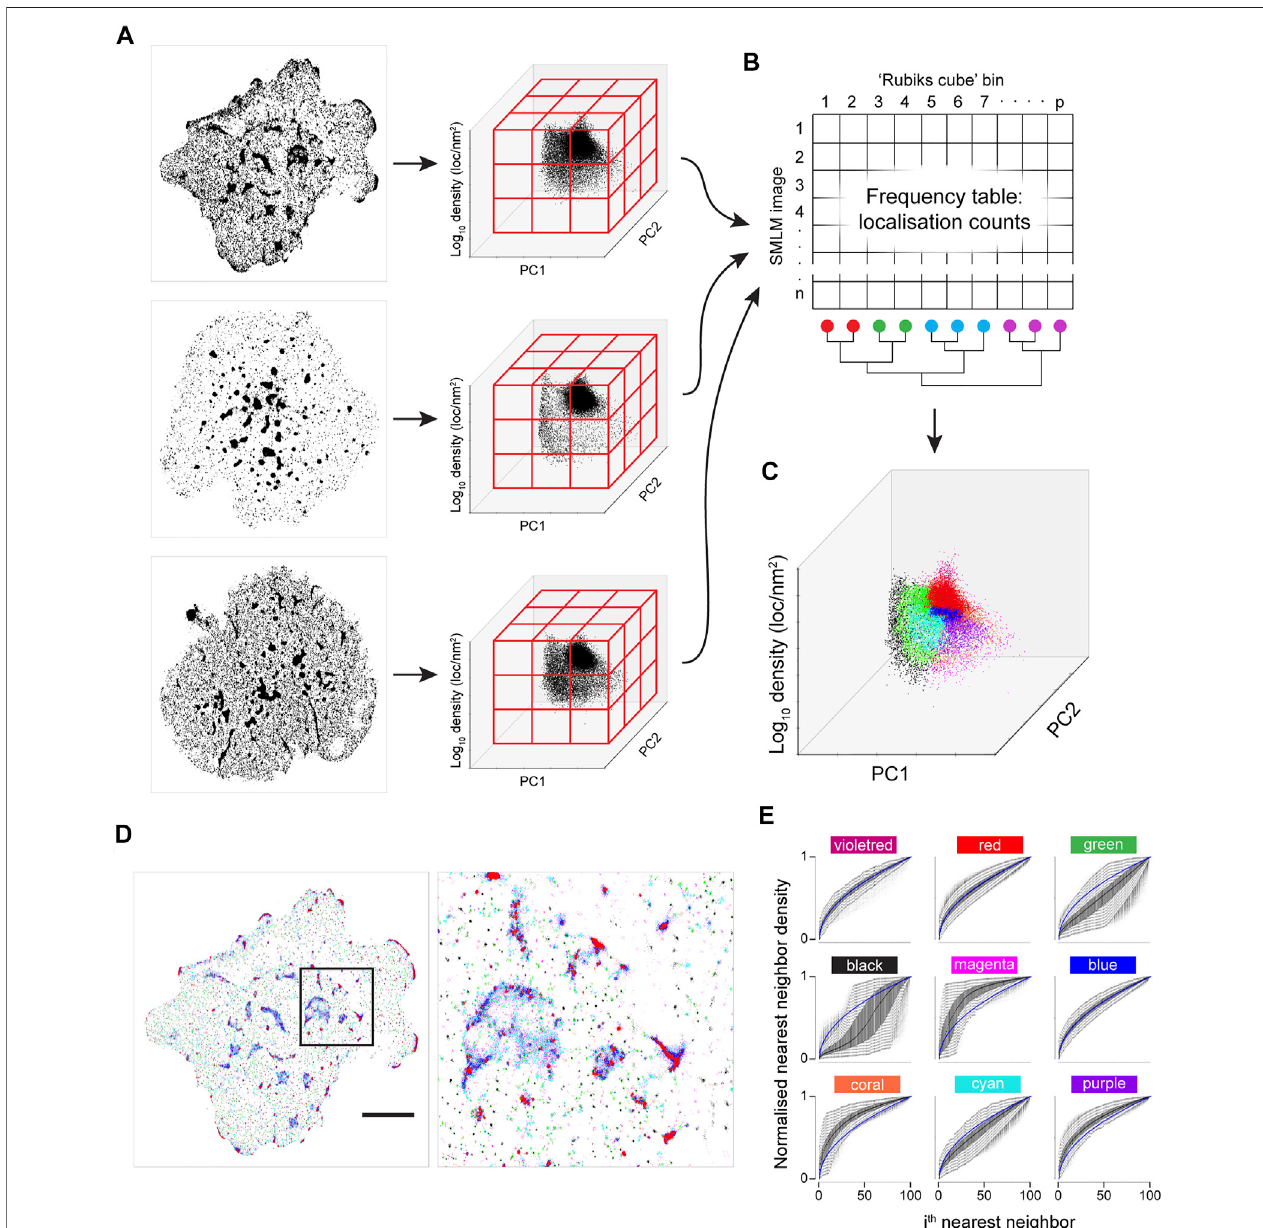
FIGURE 5 | Joint K-neighbourhood analysis over a set of diverse SMLM images. SMLM data are from ILA TCR, fi rst gen CAR and second gen CAR in Jurkat cells activated on supported lipid bilayers containing ICAM-1 and pMHC or CAR ligands. (A) Each image is converted into topological coordinates, and the ensuing cloud of points is discretised using a 50 × 50 × 50 grid that is common to all images. Example images of TCR (top panel) , fi rst gen CAR (middle panel) and second gen CAR (bottom panel) are shown. (B) The number of localisations in each bin is counted and the grid is unfolded to yield a count vector. The count vector forms a frequency table, where each image is now represented by a row of the frequency table. The bins (columns) are clustered to give localisation groups that have a similar frequency pro fi les across all images. (C) The colour key derived in (B) is transferred to the topological coordinate system. (D) . The colour key is transferred back to the SMLM image. Scale bar (cid:1) 5 μ m. (E) Density-normalized nearest neighbour distances (NND) from the entire dataset for the fi rst K (cid:1) 100 neighbouring localisations for each of the nine spatial organisations arranged in the pattern of the 2-D plot in a. identi fi es differences in local topology. Colour key as in (C) .